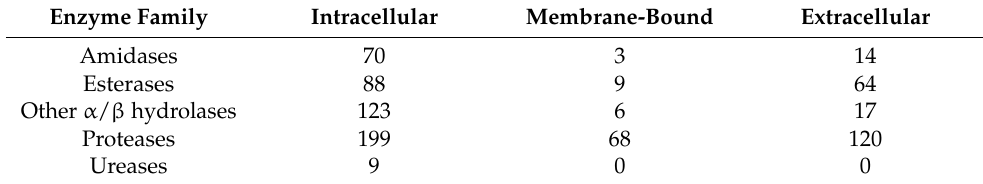
Table 3. PU depolymerization-associated enzyme families in the predicted proteome of A. mediterranei